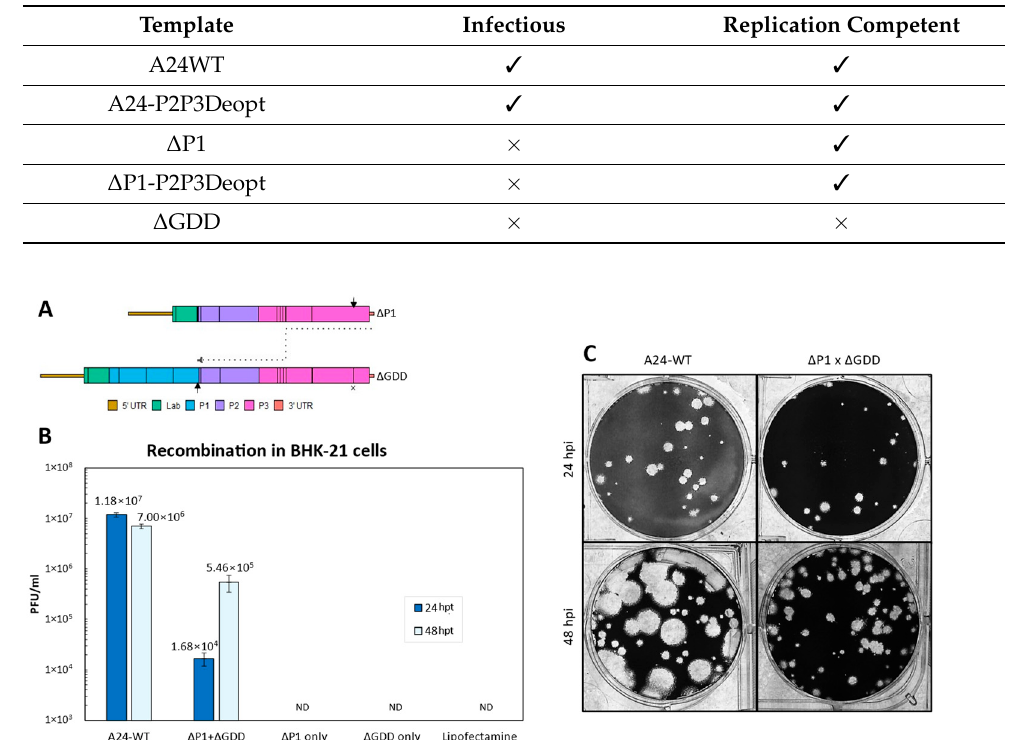
Figure 2. ( A ). Schematic model of FMDV recombination during negative-strand synthesis with the given templates. Δ GDD within the active site of RdRp encoded by 3D is indicated by an X. Template switching must occur between the two arrows. ( B ). Number of infectious particles generated 24 and 48 h post-transfection in BHK-21 cells. Error bars represent 1 standard deviation. ND—not detected. ( C ). Plaque morphologies of WT and recombinants in LFBK- α V β 6 cells stained at 48 hpt.